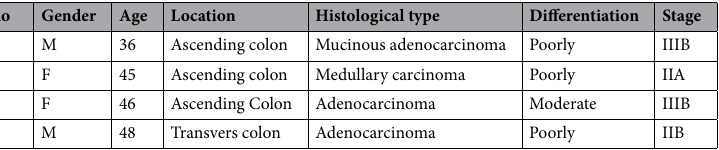
Table 1. Clinicopathological features of four tumor samples (discovery cohort). *Sample 5 was paired normal of tumor sample no.